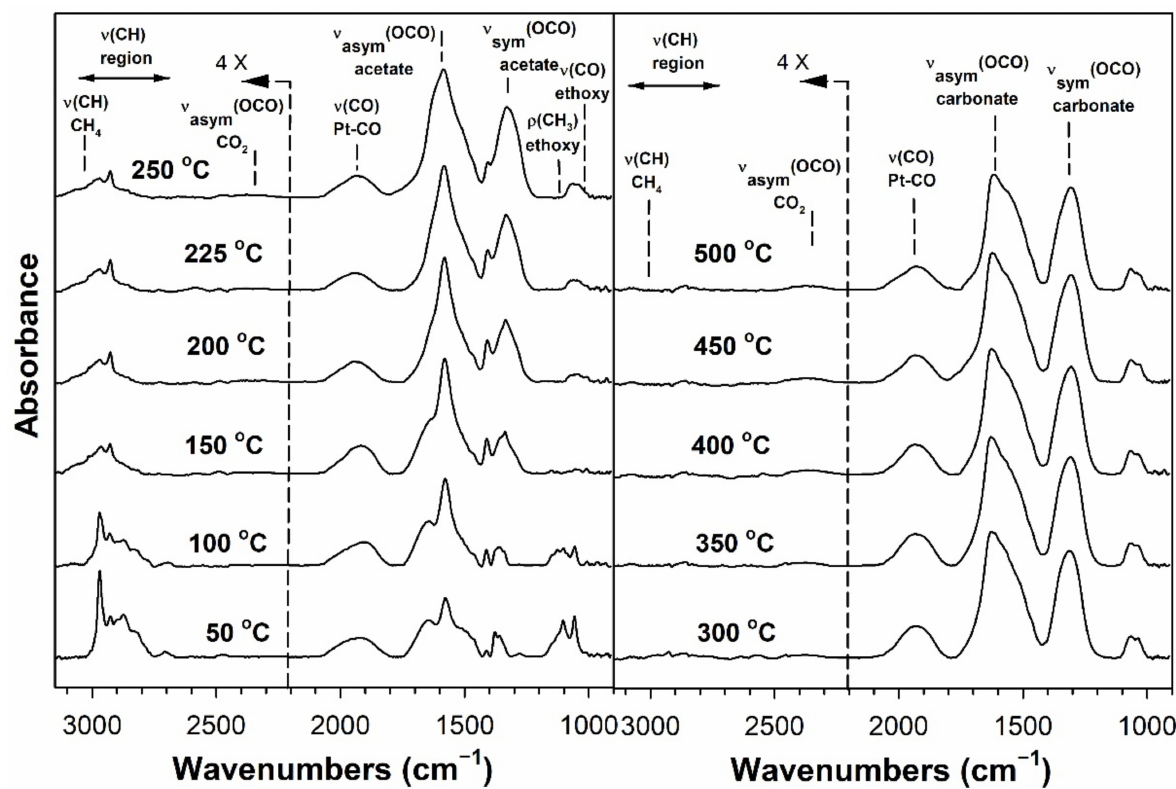
Figure 6. DRIFTS spectra of transient ESR over 2.55% K-2% Pt/m-ZrO 2